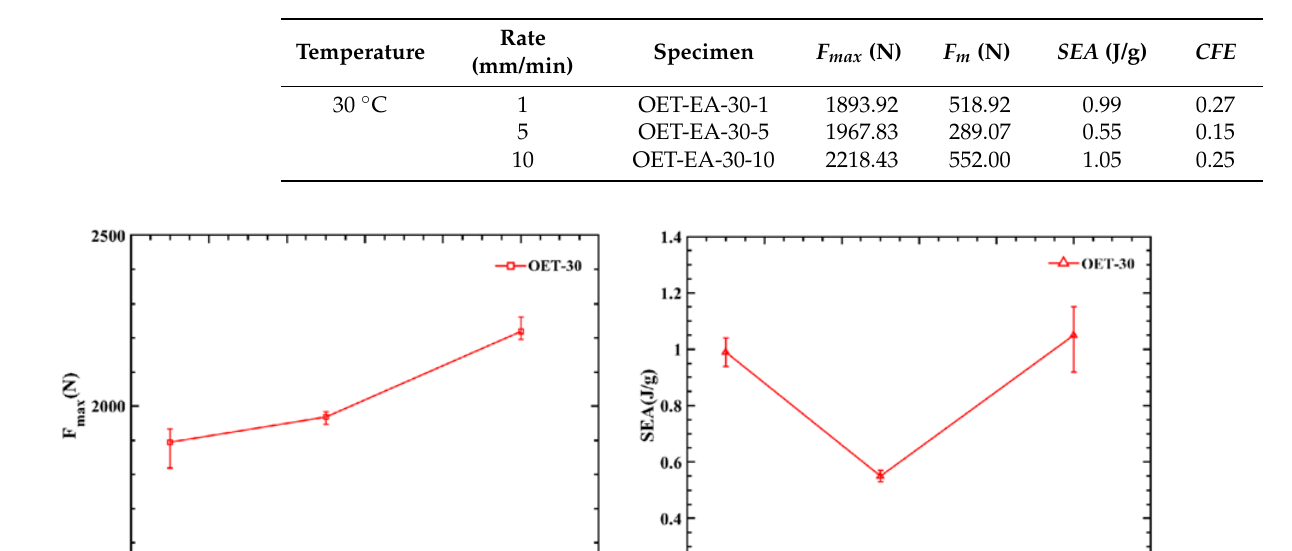
max , ( b ) SEA , and ( c ) CFE